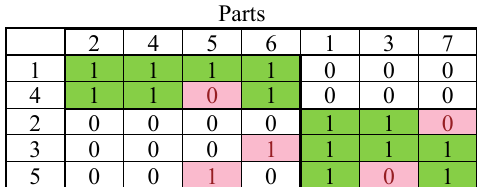
Fig. 9. Optimal 2-cell solution with minimum sum of voids and exceptions